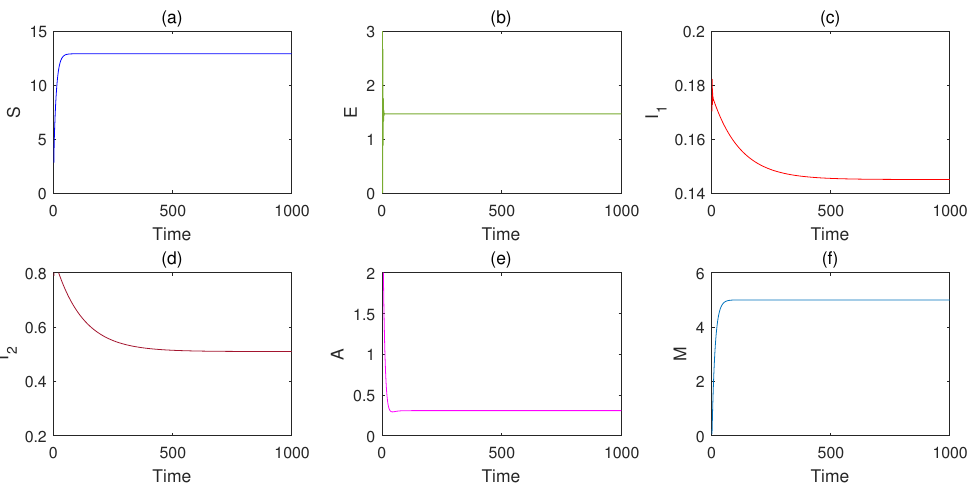
Figure 2. Infectious disease becomes endemic, and each population converges to the corresponding steady state, which shows that endemic equilibrium P ∗ ( 12.9042,1.4669,0.1451,0.5112,0.3085,5 ) is globally asymptotically stable. ( a ) The dynamical responses of S . ( b ) The dynamical responses of E . ( c ) The dynamical responses of I 1 . ( d ) The dynamical responses of I 2 . ( e ) The dynamical responses of A . ( f ) The dynamical responses of M